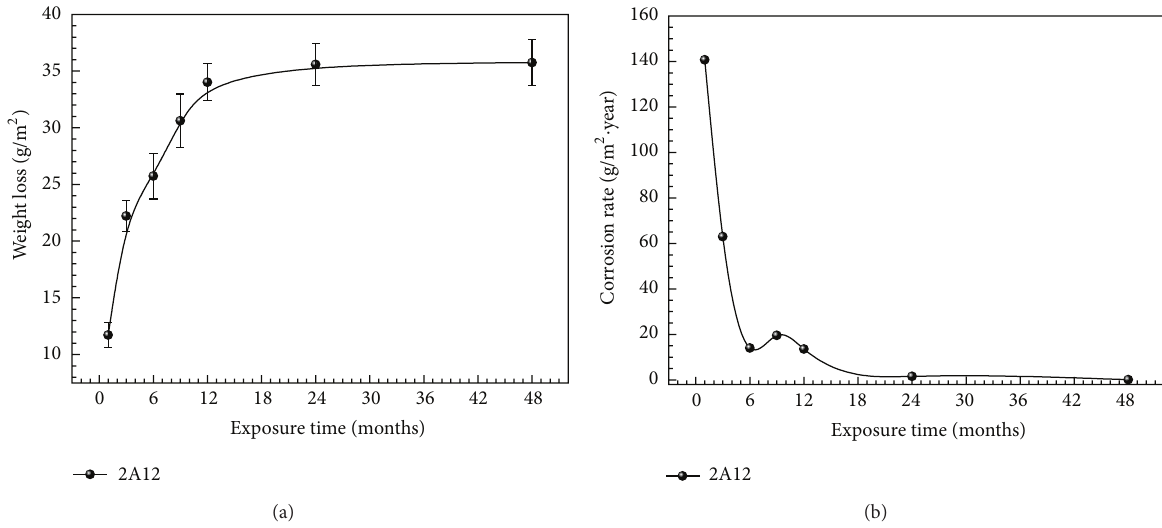
Figure 4: Weight loss (a) and corrosion rate (b) of 2A12 aluminum alloy during exposure in Xisha marine atmosphere for 4